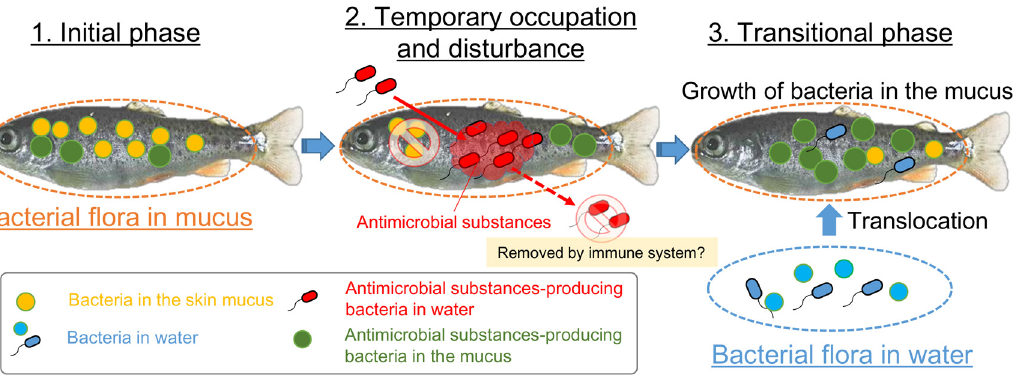
Figure 8. The proposed mechanism of the occupation, disturbance, and transition of the fish epidermal mucus bacterial flora by the bacteria with antimicrobial activity. The antimicrobial bacteria in the mucus and water contribute to the frequent change of the epidermal mucus microflora by occupying and disrupting the flora through the production of antimicrobial substances; this might cause a fluctuation in the proportions of epidermal mucus bacteria species and the transition of the flora by promoting the translocation of bacteria in the water and the growth of the indigenous mucus bacteria.